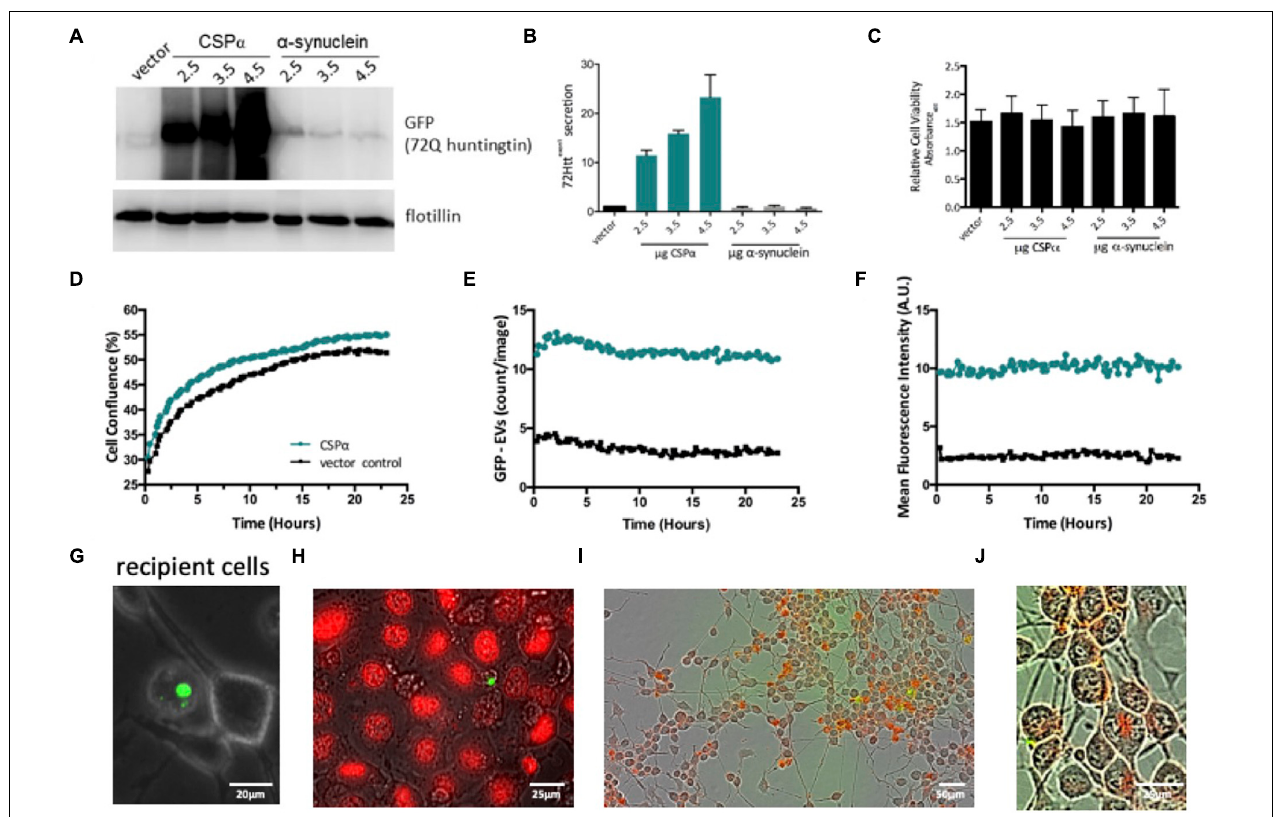
FIGURE 4 | Characterization of EVs. (A) Western analysis of EVs collected from CAD cells expressing GFP-tagged 72Q Htt exon1 and CSP α or α -synuclein (control protein). Blots are probed for GFP and flotillin. Western blot is representative of 4 independent experiments. Flotillin is shown as a loading control. (B) Bar graph quantifying western analysis of exported GFP-tagged 72Q Htt exon 1 . (C) Relative cell viability of CAD cells following media collection. (D) IncuCyte live cell analysis of recipient cell confluence following application of EVs to naïve cells in 6 well plates. Green represents EVs from cells expressing CSP α and GFP-mutant huntingtin, black represents EVs from cells expressing vector (control) and GFP-mutant huntingtin. (E) Number of large EVs containing GFP (puncta intensity = 1, rdiameter = 10 averaged over 18 images). (F) Fluorescence intensity of large EVs containing GFP (relative units; mean from 18 images). (G) Representative EVOS fluorescent image of a large EV and recipient cells. (H) EVs containing GFP-tagged huntingtin aggregates and naïve CAD cells were stained with DRAQ5 for DNA and imaged with widefield fluorescence and brightfield microscopy. (I,J) EVs (not enriched) were labeled with Deep Red stain, applied to recipient cells, incucyte images are 12 h after EV